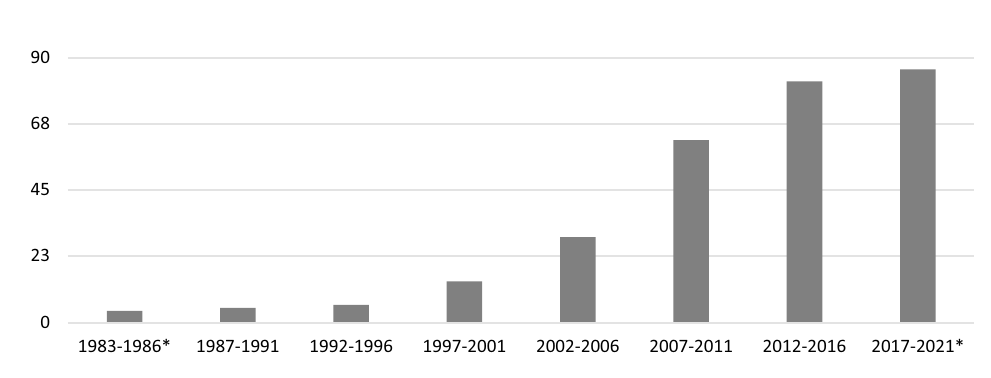
Fig. 2 Overview of the included articles (number) per 5 years